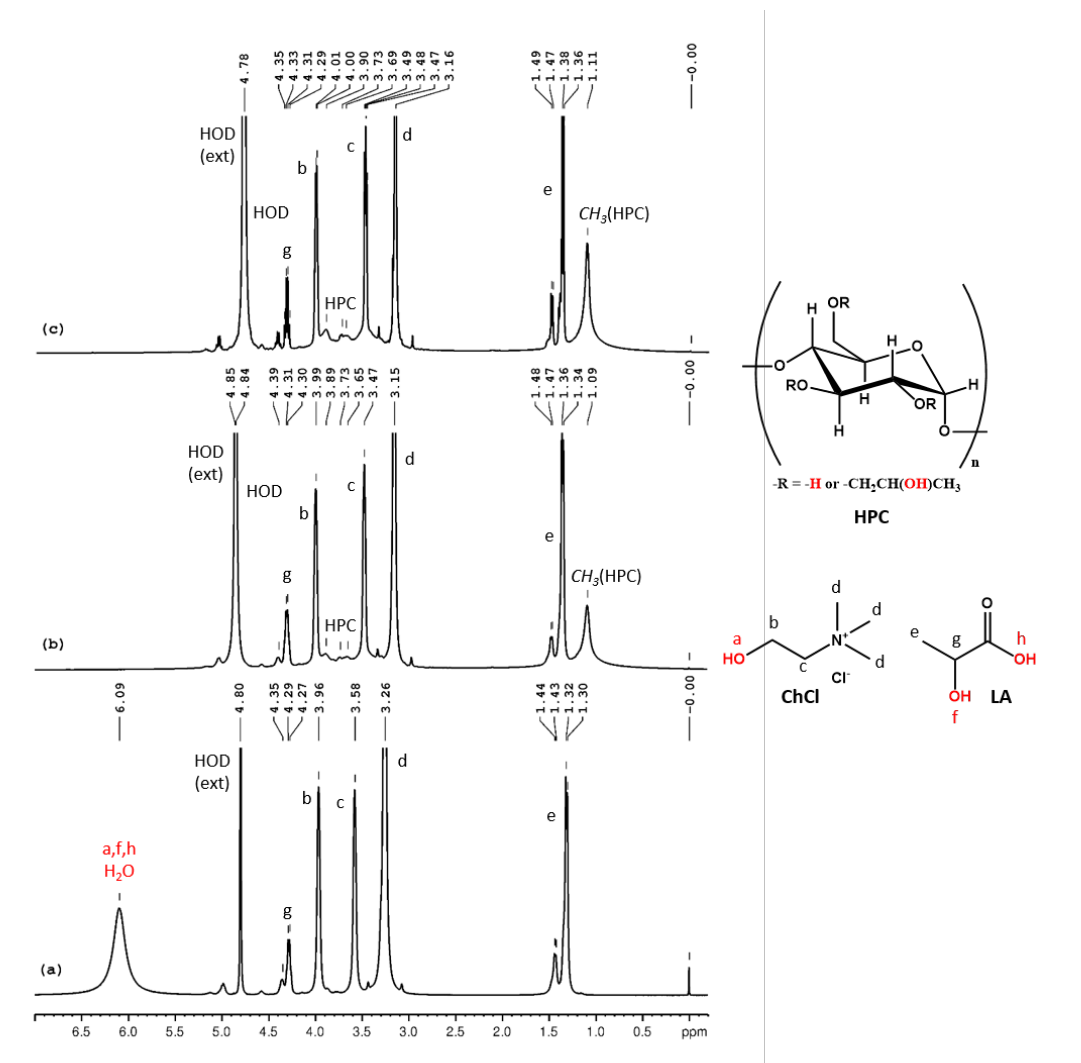
Figure 5. 1 H NMR spectra of ChCl-LA ( a ), HPC-ChCl-LA 29% ( b ) and HPC-ChCl-LA 17% ( c ). In red color are marked the exchangeable protons.